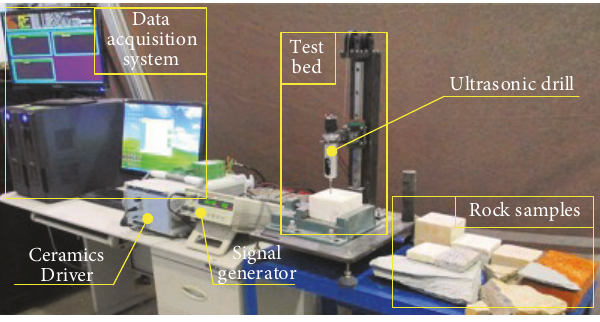
Figure 12: Test and experiment system of ultrasonic